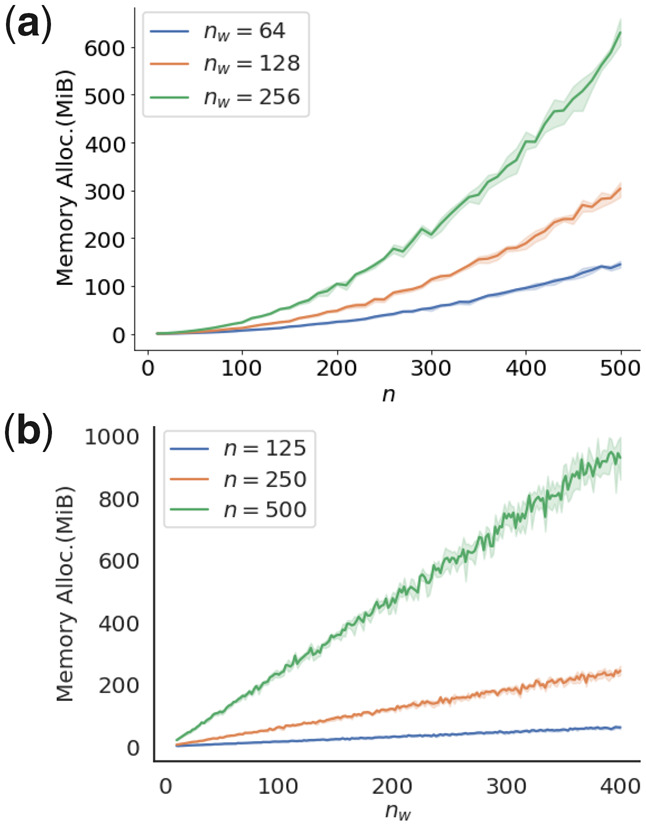
Memory allocation as a function of set size and bin size for Green Cuda. We plotted the required memory allocation to calculate P values for samples from yA∼N(0,1) and yB∼N(0,1) for different sample sizes n and bin sizes nw. In (a) the nw used were 64, 128 and 512 with 5 replicates, and in (b) n were 125, 250 and 500 with 5 replicates